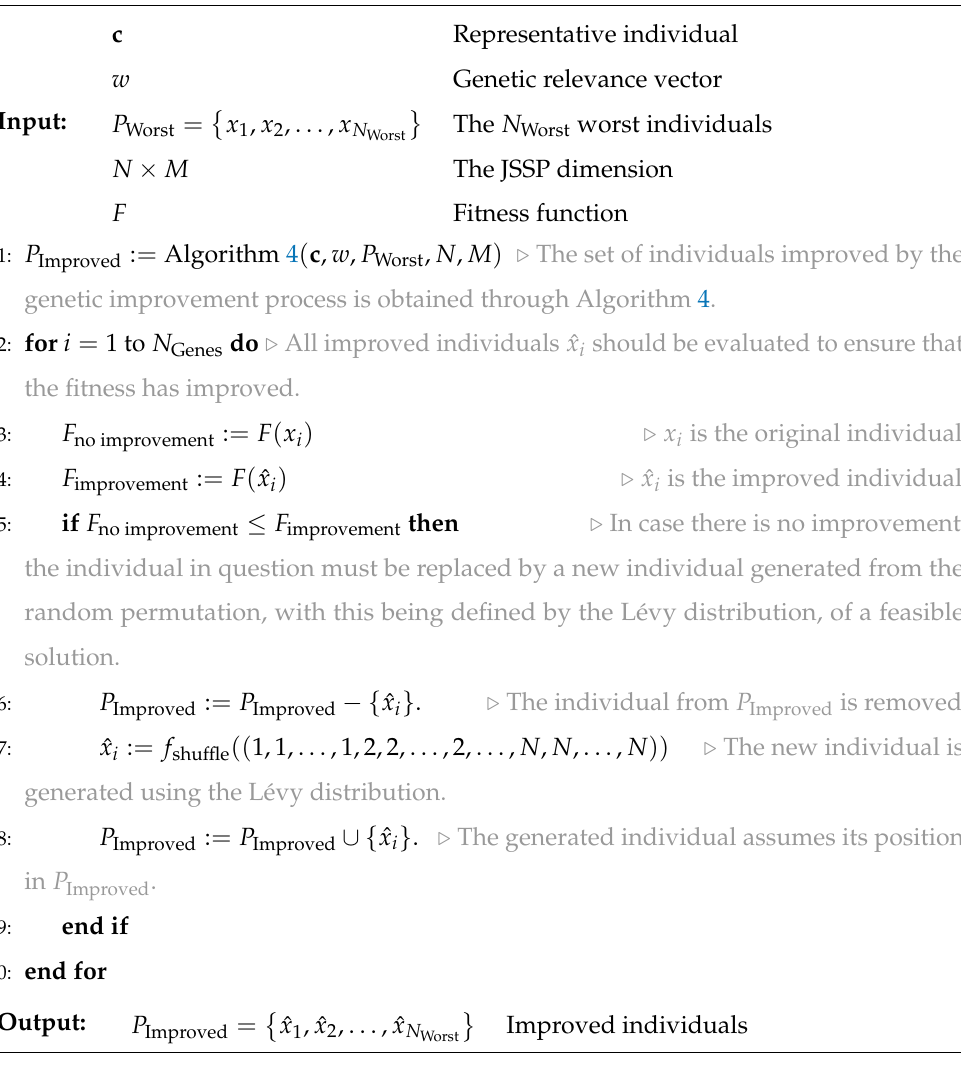
Algorithm 5 Population improvement with diversity